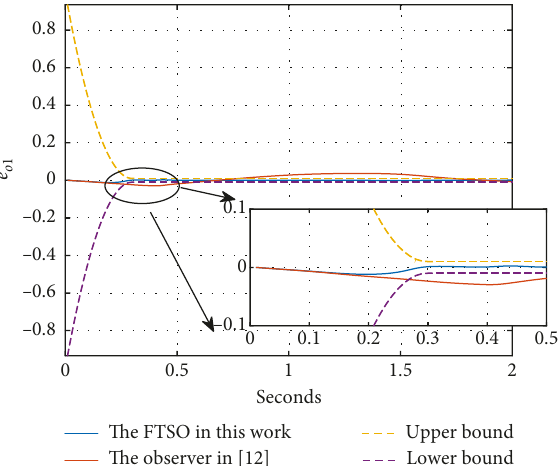
Figure 8: The observer compared results of e